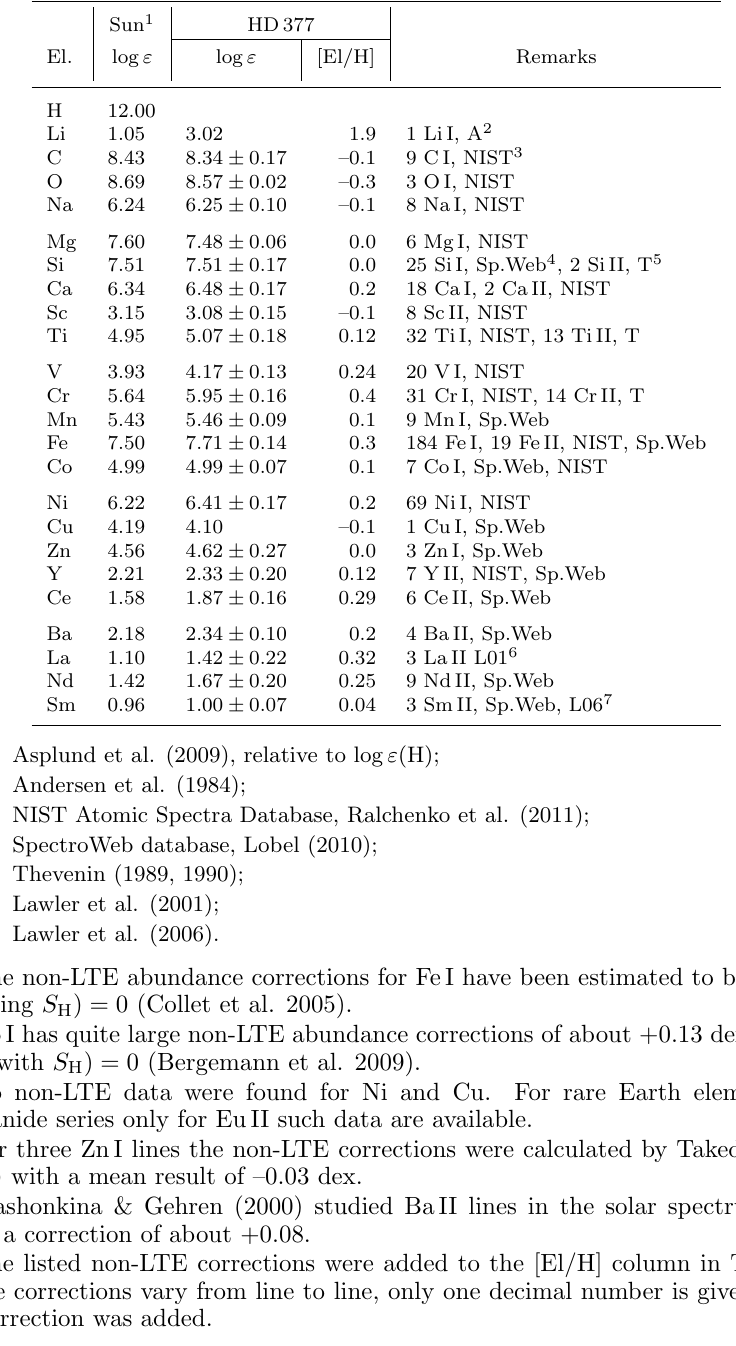
Table 2. The chemical composition of HD 377. In the Remarks numbers of the used lines and the sources of oscillator strengths are